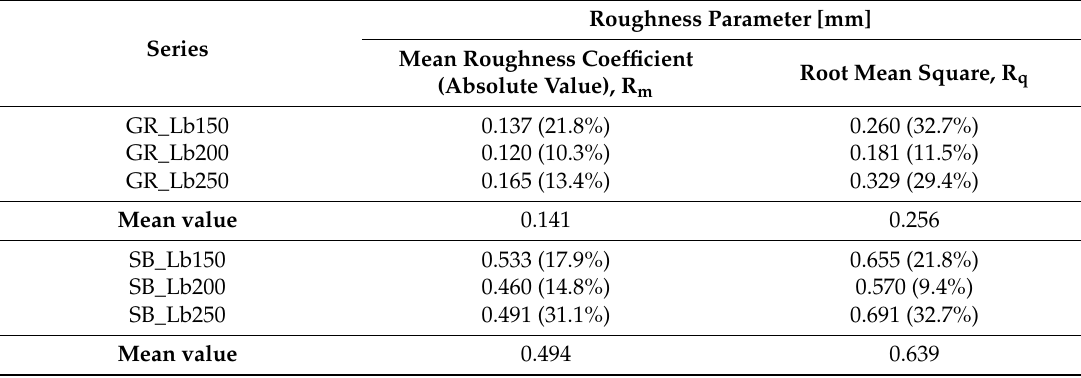
Table 2. Results from the roughness assessment (average